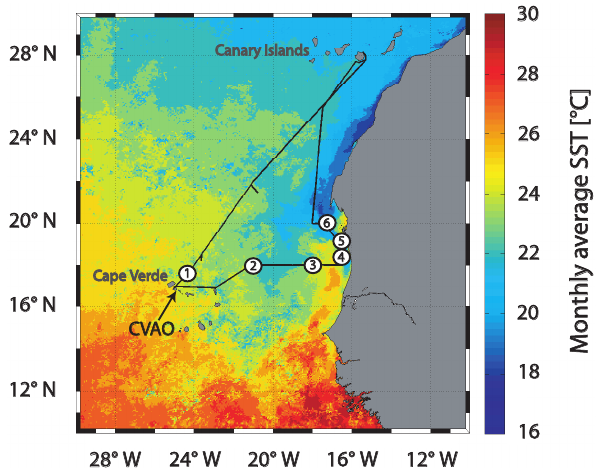
Fig. 1. Cruise track (black line) during DRIVE on SST derived from the monthly composite of June 2010 of MODIS-Aqua level 3 data. White circles with black numbers indicate 24h-stations. Also marked is the location of the CVAO (Cape Verde Atmospheric Ob-